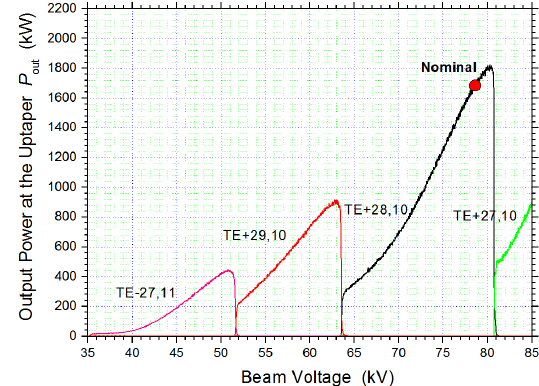
Fig. 2. Multi-mode simulation (36 competing modes) of the diode start-up for gyrotron operation at 140 GHz. A negative azimuthal index denotes a counter-rotating mode.